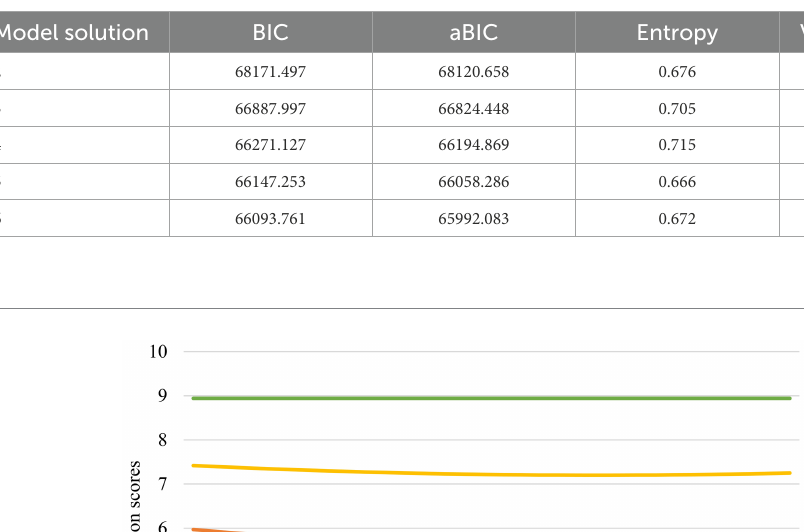
TABLE 4 Model fit statistics for 2 to 6 profile models.